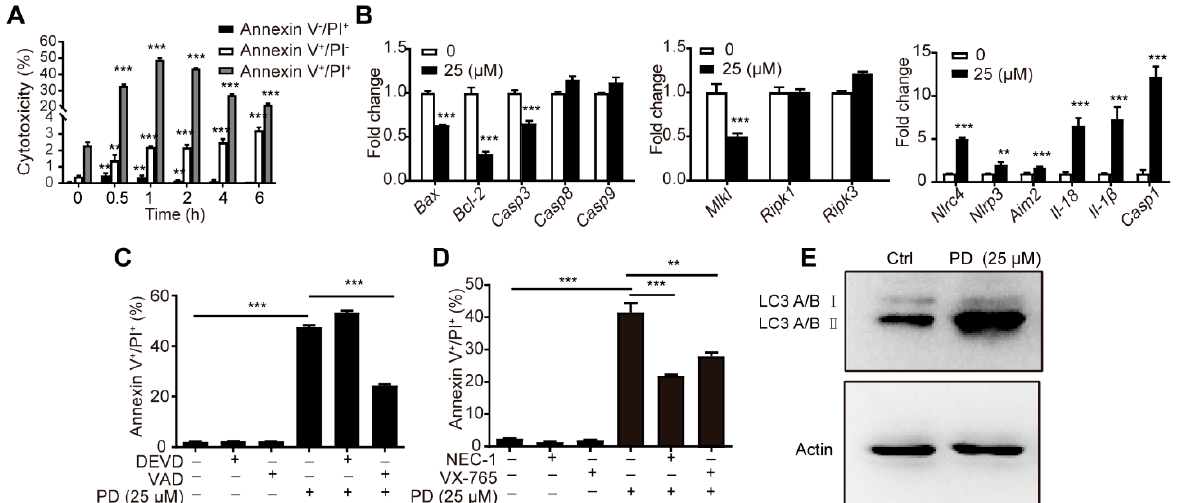
Figure 5. Multiple cell death pathways were involved in PD-induced cytotoxicity. ( A ) The proportion of Annexin V + /PI - (early apoptotic), Annexin V + /PI + (necrotic-like), and Annexin V - /PI + (necrotic) in C2C12 cells after stimulation with PD (25 μ M) at the indicated time. ( B ) The gene expression of biomarkers associated with cell apoptosis, necroptosis, and pyroptosis by RT-qPCR after stimulation with PD (25 μ M) for 4 h. Casp1/3/8/9, caspase-1/3/8/9. ( C , D ) The proportion of Annexin V + /PI + (necrotic-like) cells in C2C12 cells pretreated with indicated inhibitors before PD (25 µ M) stimulation for 1 h. ( E ) C2C12 cells were stimulated with PD (25 μ M) for 30 min, and the LC3A/B II protein levels were analyzed by immunoblotting. The figures shown were representative of three independent experiments. Data were presented as mean ± SD ( n = 3). (**) p < 0.01, (***) p < 0.001, ns not